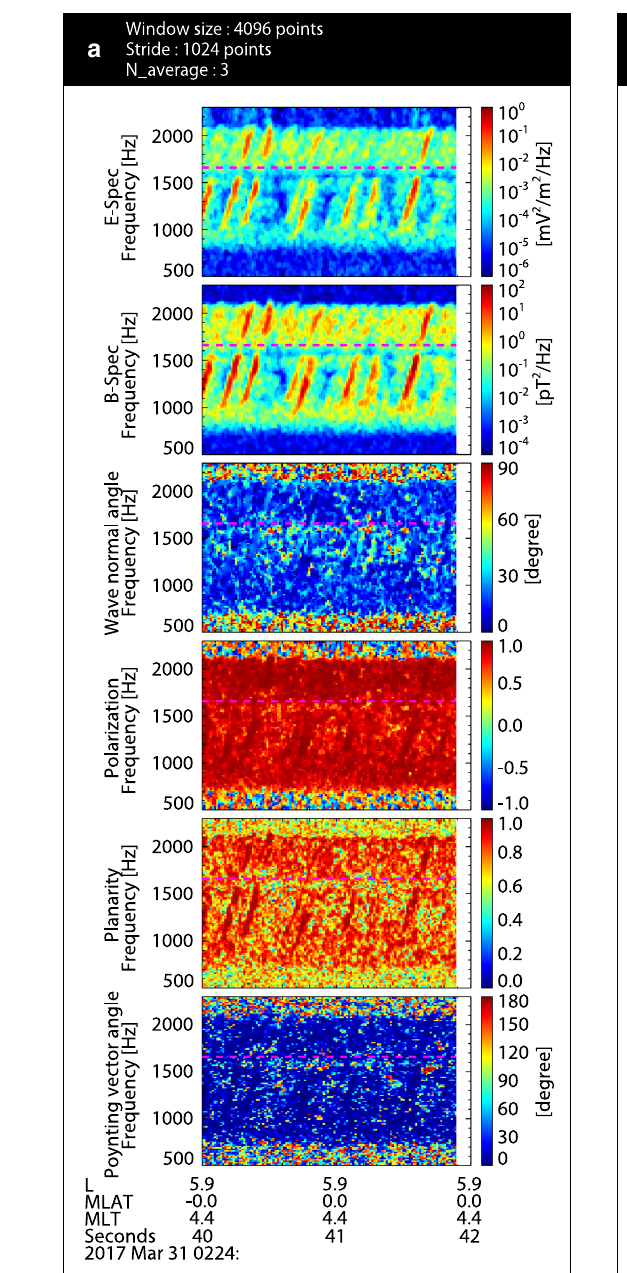
Fig. 6 Examples of results for different N average ; a N average = 3 , b N average =